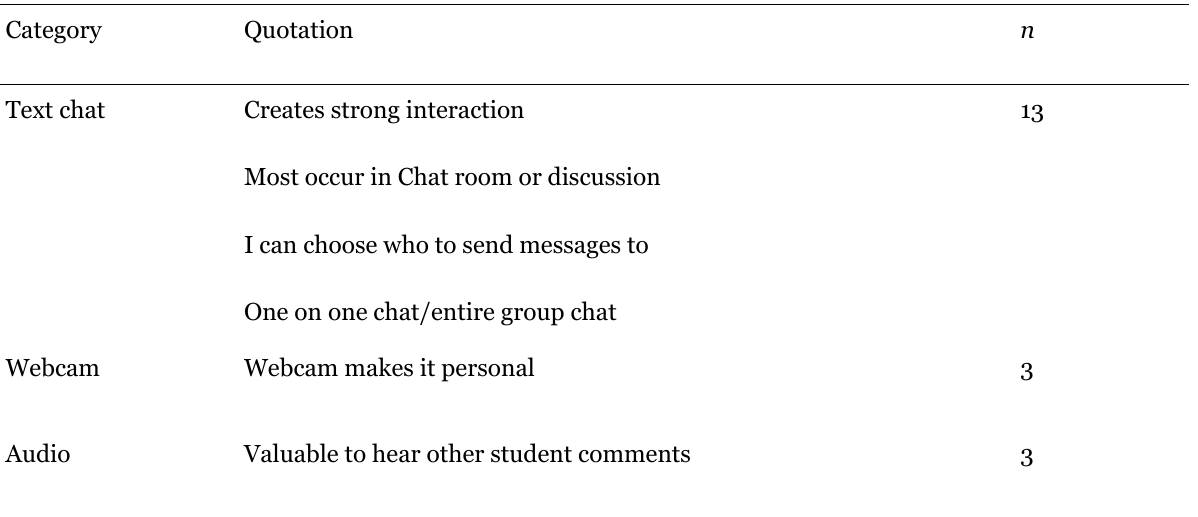
Student Responses to Learner-Learner